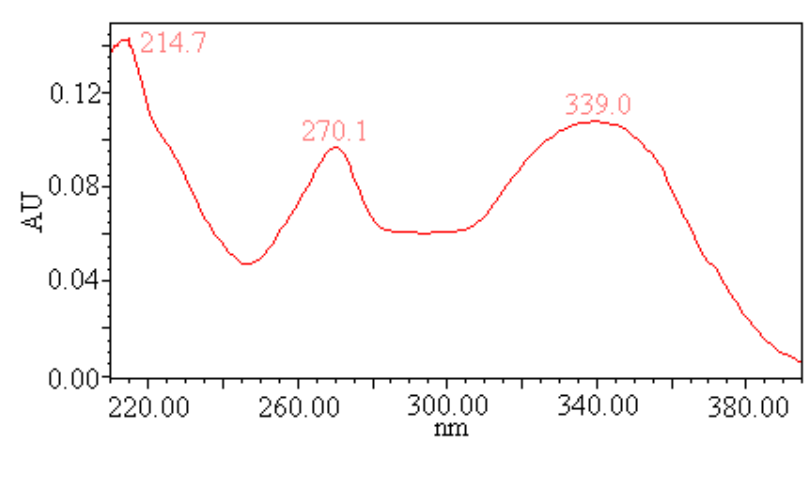
Figure 7. UV spectrum of compound